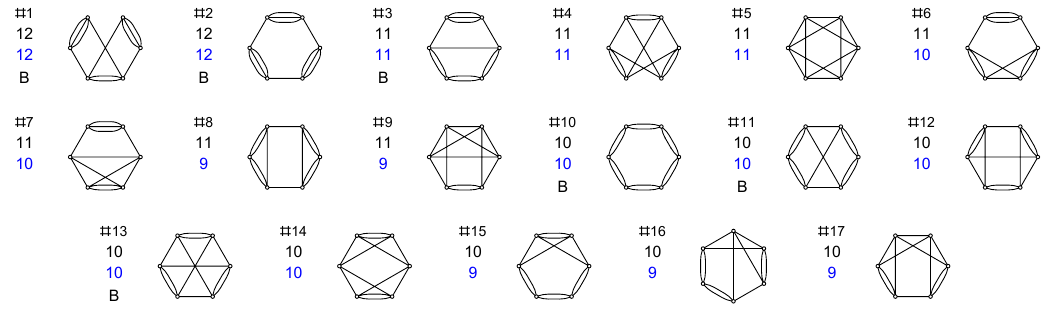
Figure 6 . All vacuum diagrams of order g 6